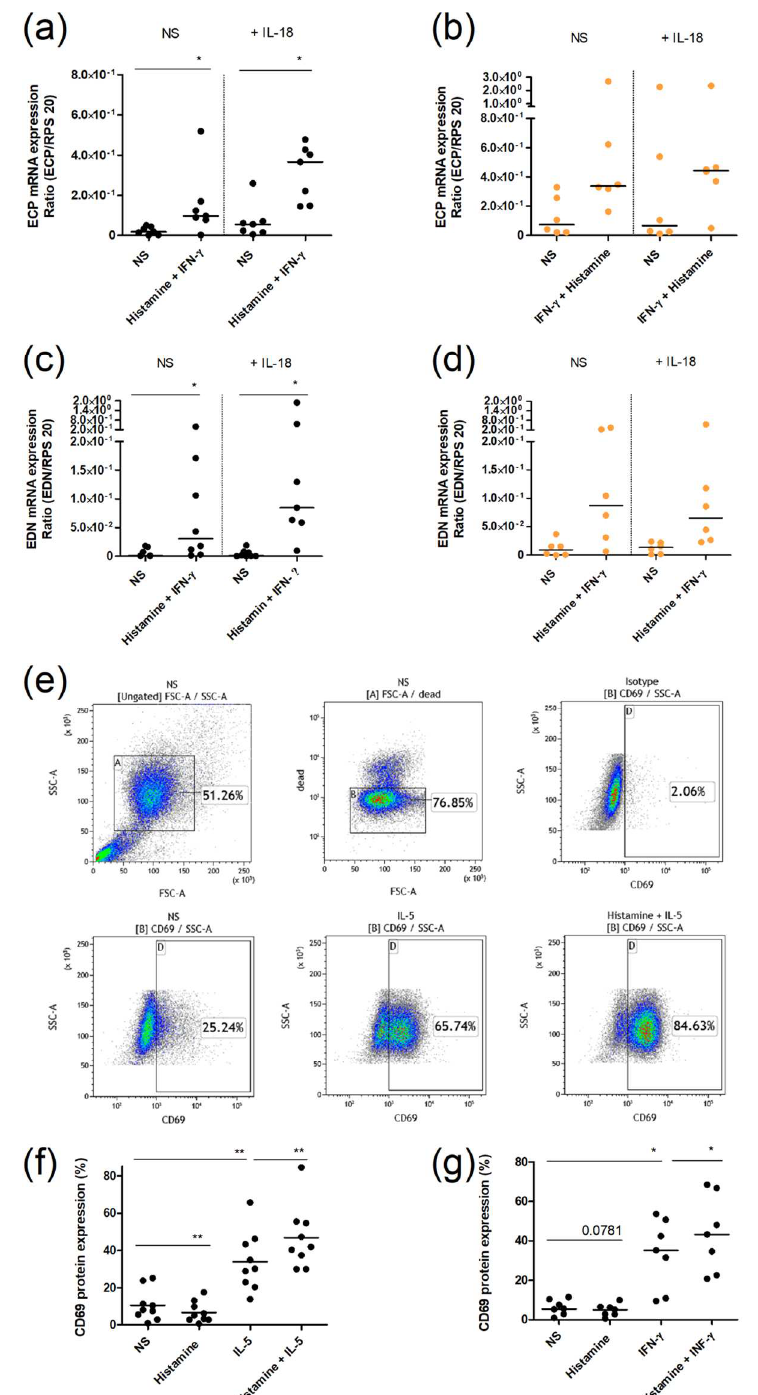
Figure 6. Histamine potentiates the activation of human eosinophils. ( a – d ) Purified eosinophils from AD patients (black) and healthy controls (orange) were stimulated in duplicate with histamine (10 μmol/L) combined with INF-γ (10 ng/mL) for 18 h or were left unstimulated. Cells were then washed with PBS and fresh culture media was added. Subsequently, one approach was stimulated with IL-18 (10 ng/mL) for 6 h, while the other approach was left unstimulated as control. The mRNA expression levels of ECP and EDN were measured by real-time PCR. ( e – g ) Purified eosin- ophils from AD patients (black) and healthy controls (orange) were stimulated with histamine (10